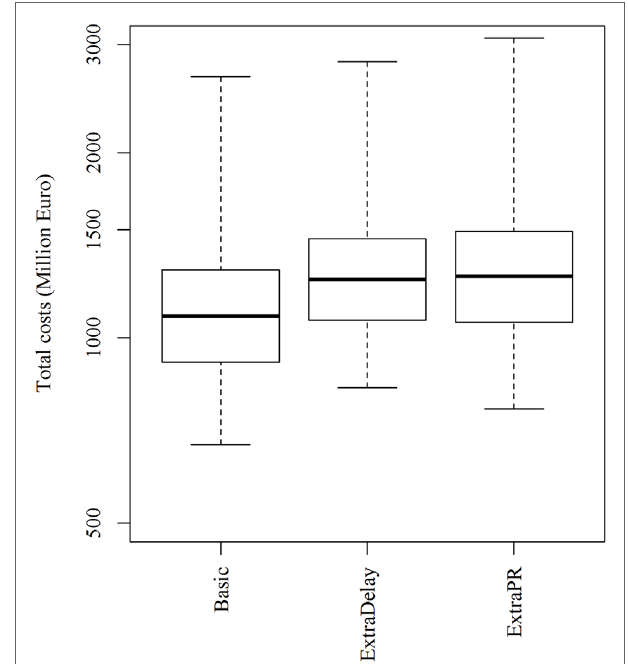
FigUre 6 | Total costs of simulated FMD epidemics using the basic control scenario, which represents the eU and Danish control measures, when the free status was regained 3 months (basic) or 6 months (extraDelay) after the depopulation of the last detected herd, and when products intended for export to non-eU countries were sold in the eU market with a price reduction of 25% (basic) or 50% (extraPR) . Epidemics were initiated in cattle